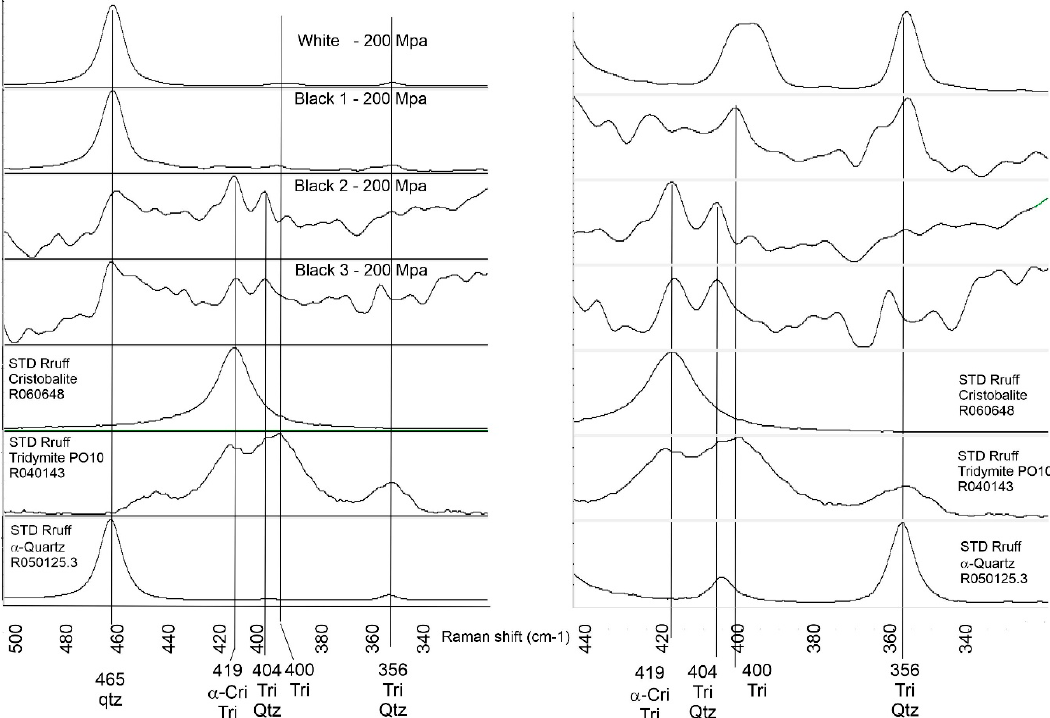
Figure 12. Raman spectra of stressed quartz fragments; the three spectra below derive from the collection of Raman spectra included in the RRUFF collection (RRUFF Project, Department of Geosciences, University of Arizona, 1040 E 4th, Tucson, AZ, USA. 85721-0077): (Cristobalite (low)-R060648, Tridymite PO10-R040143, Quartz (low)-R050125.3); on the right, an enlargement of the area between 440